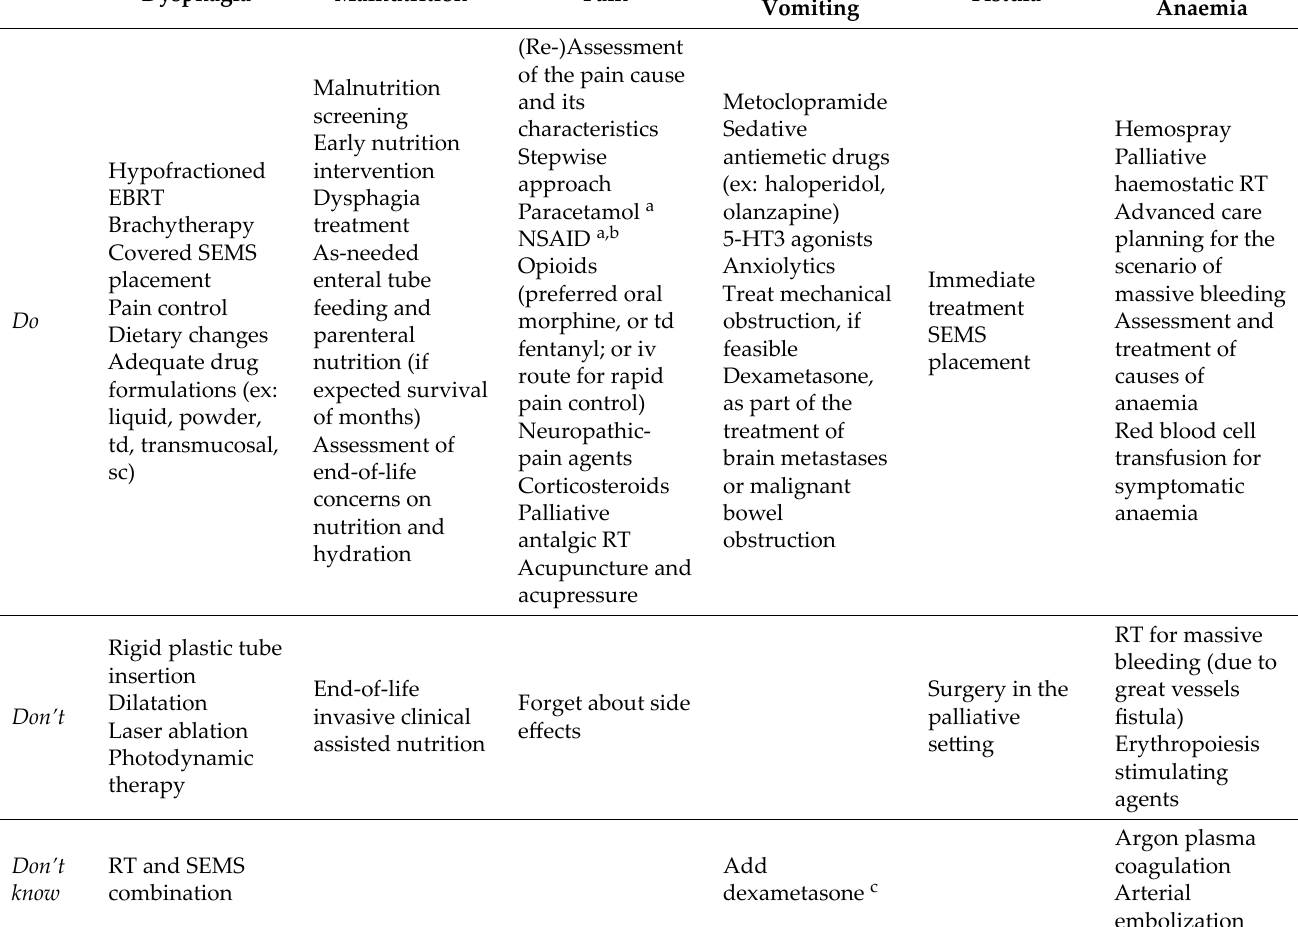
Table 1. Summary of